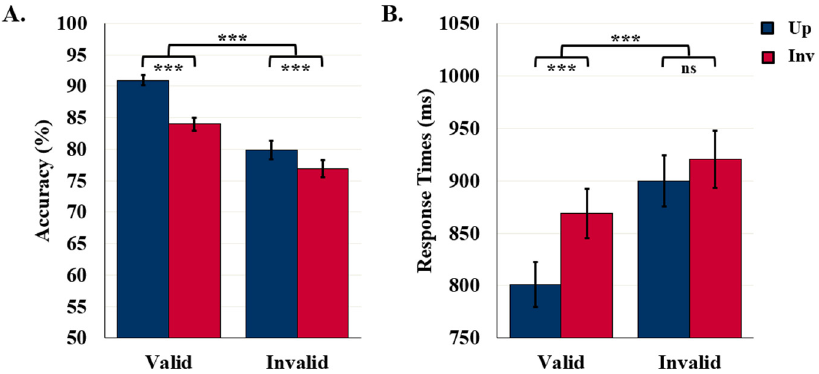
Figure 4. Results for Study 1: Invalid DSC Labels. ( A ) Object Detection Accuracy ( N = 112) and ( B ) Detection RTs ( N = 105). Error bars represent standard errors. *** indicates p < 0.001 and ns indicates non-significance.